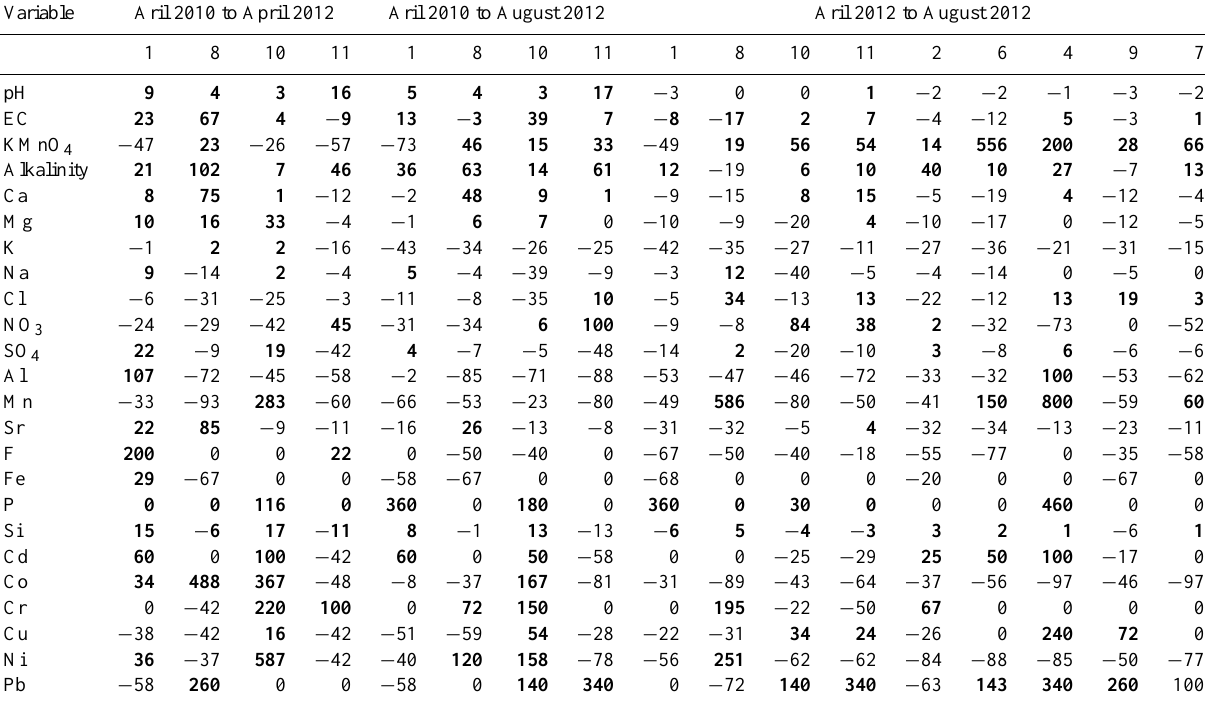
Table 6. Changes in selected dissolved concentrations (%) between seasons in different observation well locations. Numbers in the first row (1 to 11) represent observation well numbers (Obs1 to Obs11). Positive numbers are marked as bold, which indicates an increase in dissolved